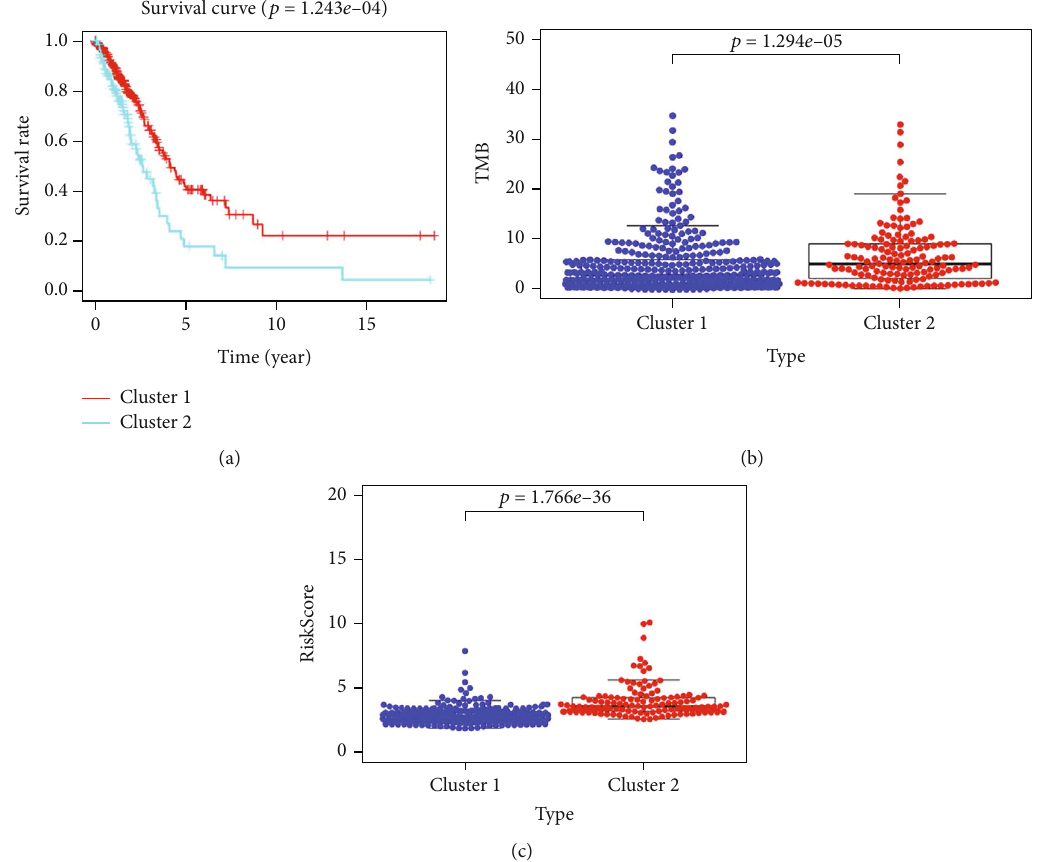
Figure 3: (a) Kaplan-Meier curves of overall survival (OS) for patients with LUAD in two clusters (cluster 1/2). (b) The TMB levels in cluster 1/2 subtypes in TCGA cohort. (c) The risk score in cluster 1/2 subtypes in TCGA